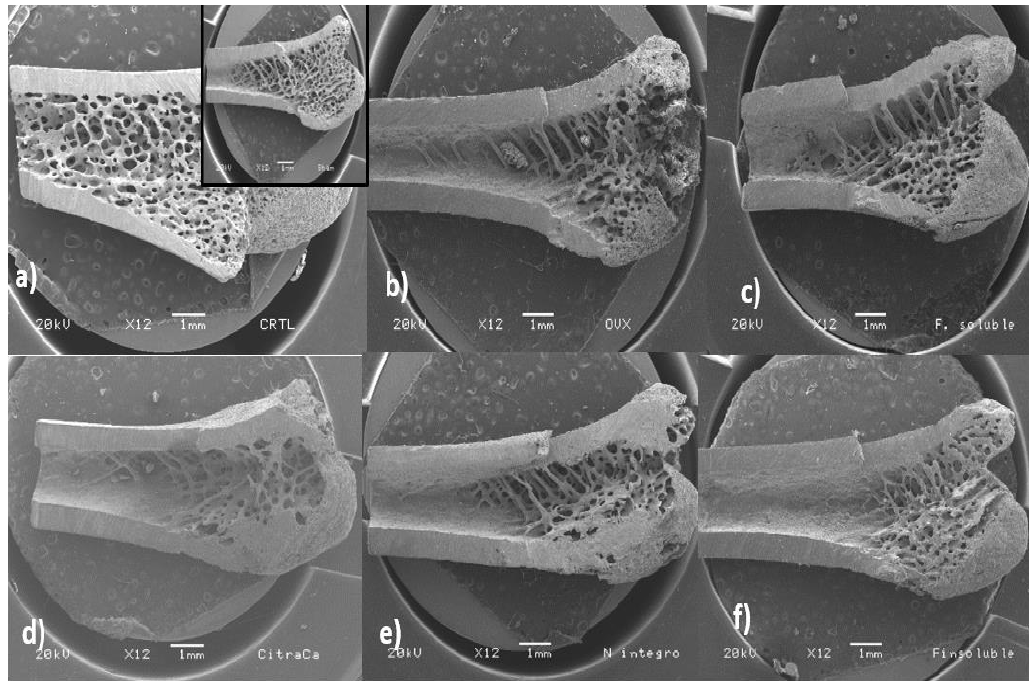
Figure 5. Scanning electron micrographs of the inner part of the femur (longitudinal cut from the line between condyles in the direction to the diaphysis at 12X) of rats from the experimental groups. ( a ) Ctrl and sham (insert in the upper right) groups, ( b ) ovariectomized group fed with AIN-93M, ( c ) ovariectomized group fed with diet supplemented with soluble fiber extracted from O. ficus-indica , ( d ) ovariectomized group fed with diet supplemented with calcium citrate, ( e ) ovariectomized group fed with diet supplemented with insoluble fiber extracted from O. ficus-indica , ( f ) ovariectomized group fed with diet supplemented with O. ficus-indica